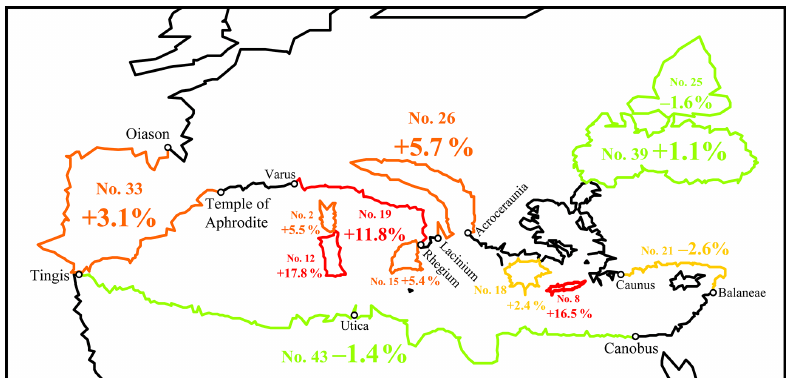
Figure 6. Differences between the coastline lengths in (cid:52) and in (cid:127) as expressed in terms of percentage of the (cid:52) values (for the same coastal stretches as shown on Fig. 3).